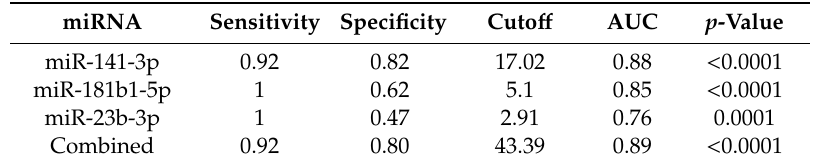
Table 3. ROC analysis of miRNAs in TNBC patients compared with other molecular subtypes of breast